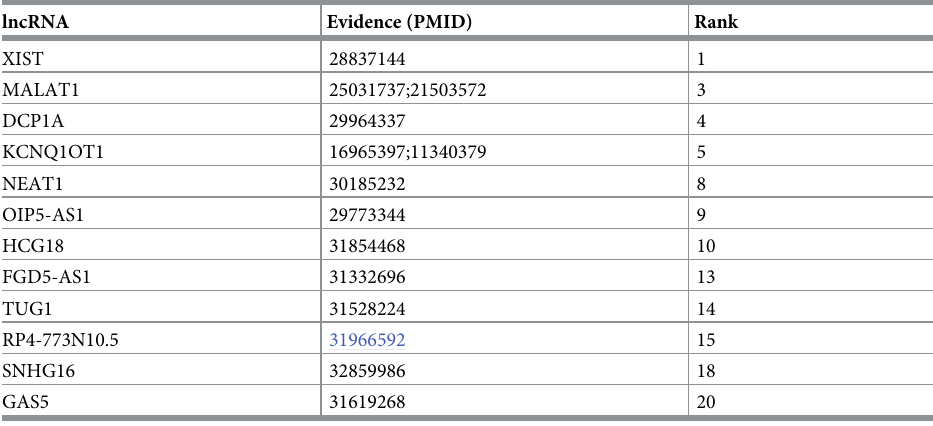
Table 2. Top 20 lncRNA of colorectal neoplasms predicted by